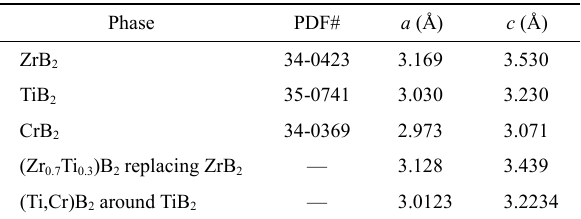
Lattice parameters of theoretical batched phases and new lattices extracted by X-ray diffraction spectrum in the sintered in ZTC-B material